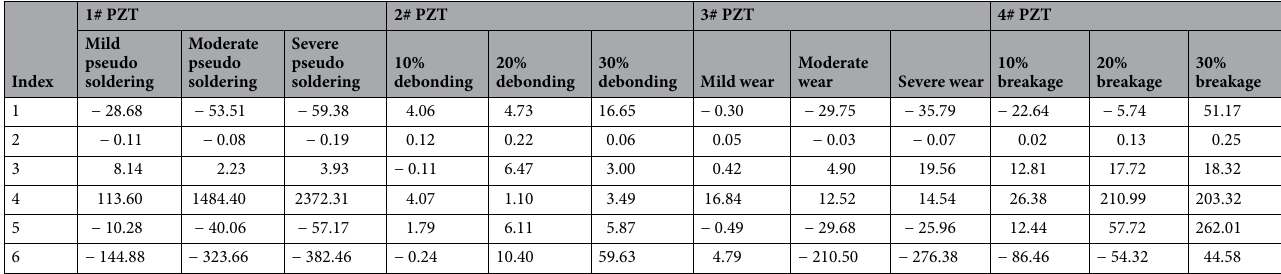
Table 3. Characteristic indexes of PZT under different damage conditions.